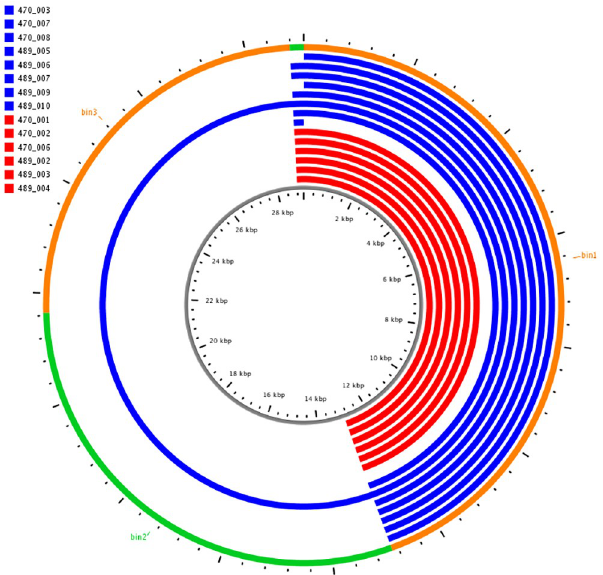
Fig 1. Comparison of accessory genome elements (AGE) of inapparent carrier SEE (n = 8), and acute clinical SEE (n = 6) genomes from Sweden. The outer ring shows the ClustAGE bins that are � 200 base-pairs in size these are ordered clockwise from the largest bin to the smallest bin, and are differentiated by orange and green to define bin borders. The concentric inner bands show the distribution of AGE within each individual isolate. Bands that are blue represents inapparent carrier isolates, and bands that are red represent acute clinical isolates. The central ruler of the figure indicates the cumulative size of the AGE in kilobases.